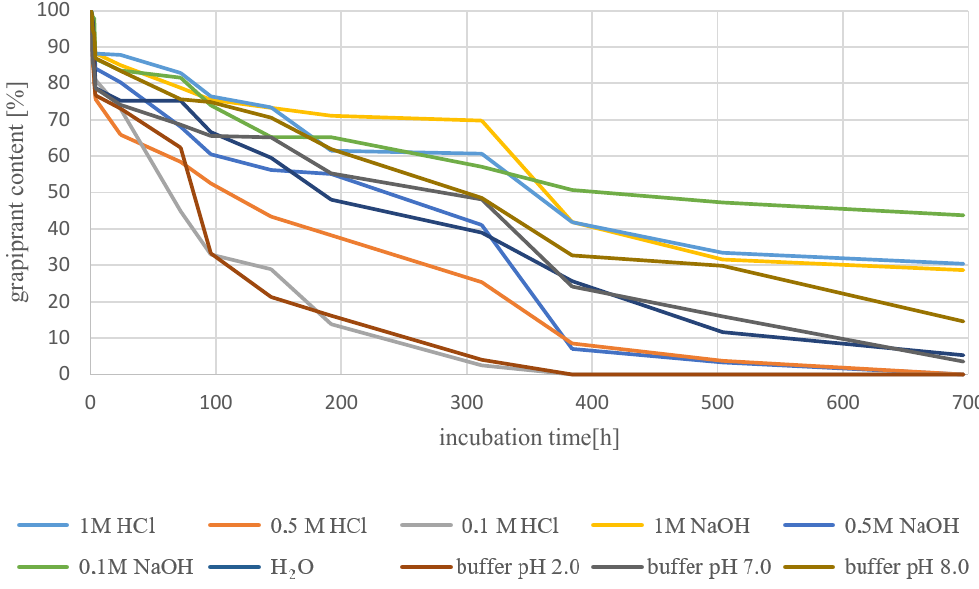
Figure 7. Percentage of grapiprant content during degradation at 70°C as pH function.